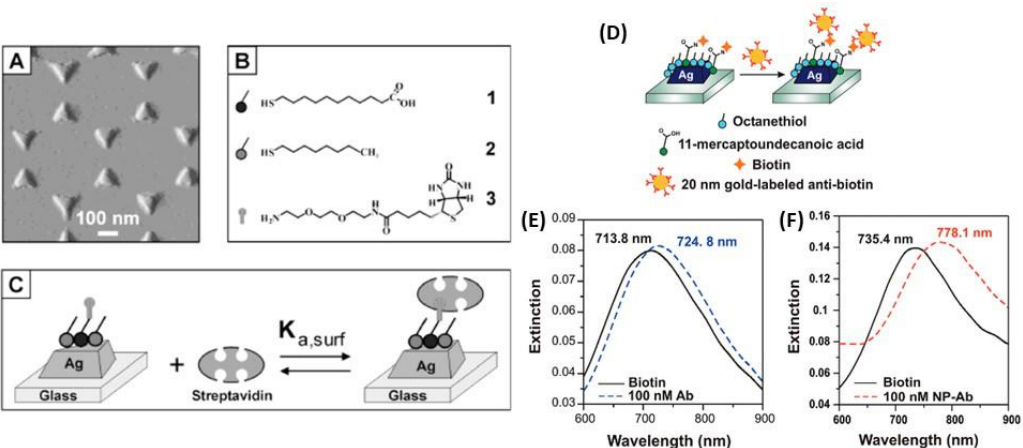
Figure 22. Silver triangular nanoparticles fabricated by NSL on a glass substrate. ( A ) Tapping mode AFM image of the Ag triangular NPs. ( B ) Surface chemistry of the Ag nanobiosensor. A mixed monolayer of (1) 11-MUA and (2) 1-OT is formed on the exposed surfaces of the AgNPs followed by the covalent linking of (3) biotin to the carboxyl groups of (1) 11-MUA. Schematic illustration of ( C ) streptavidin binding to a biotinylated Ag nanobiosensor and ( D ) biotin covalently linked to the Ag nanobiosensor surface while antibiotin-labeled AuNPs are subsequently exposed to the surface. LSPR spectra ( E ) before (solid black) and after (dashed blue) binding of native antibiotin and ( F ) before (solid black) and after (dashed red) binding of antibiotin-labeled NPs. Adapted from [57,177]. Copyright (2002, 2011), American Chemical Society.